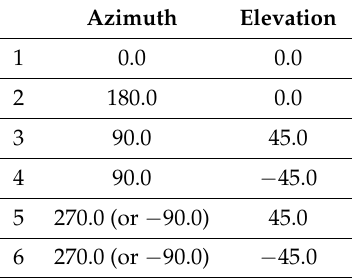
Table 2. Angle selection for training and validation